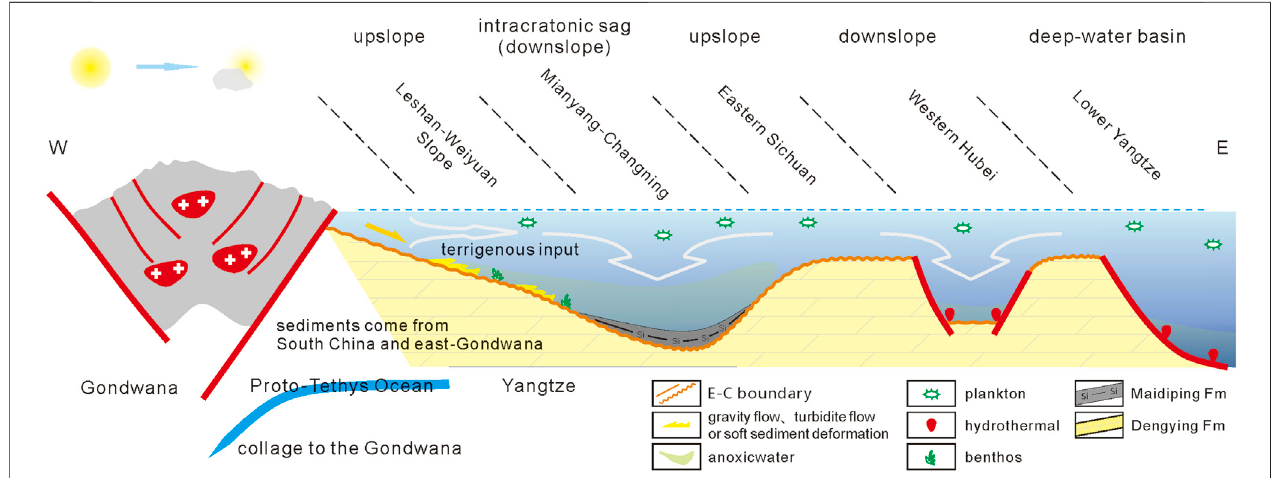
FIGURE 10 | Sedimentary paleo-ocean environment and productivity model of the Qiongzhusi Fm in the upslope area.